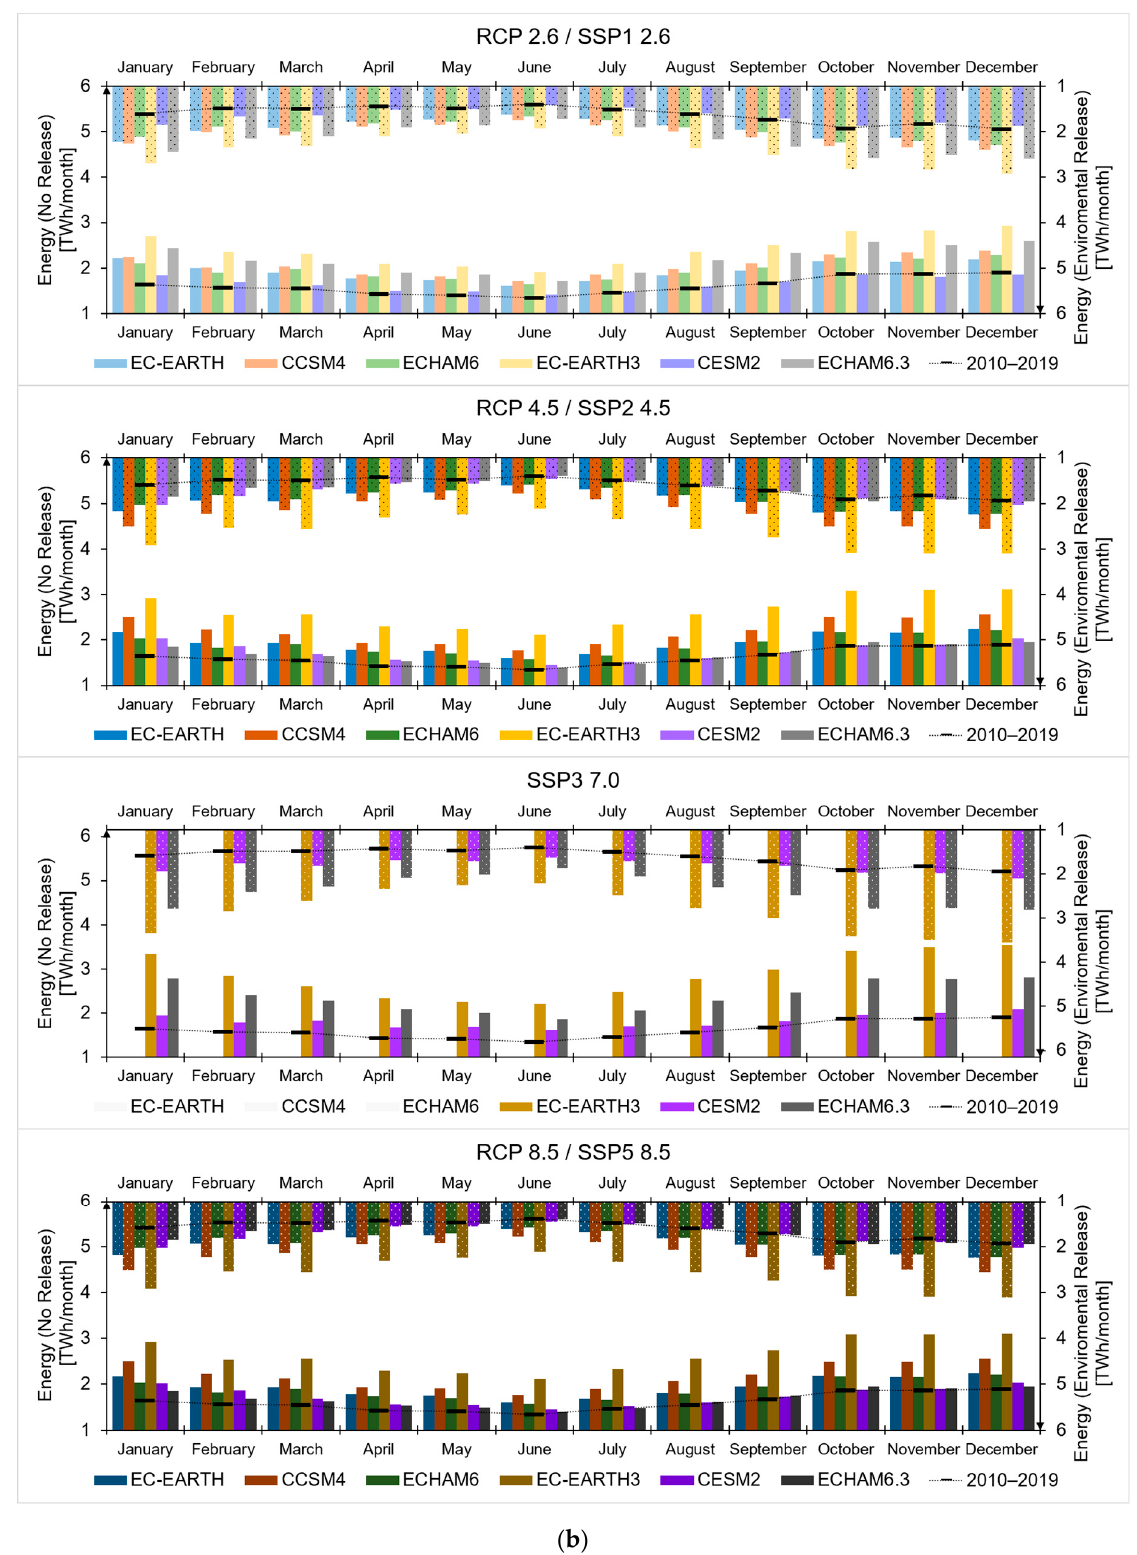
Figure 9. GERD. Average estimated monthly hydropower production. ( a ) Mid Century P1. ( b ) End of Century P2.